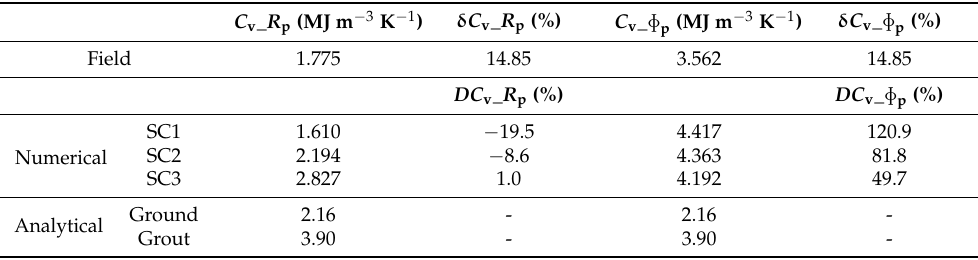
Table 11. Comparison of heat capacity obtained from the analysis of field tests and numerical simulations. HC of subsurface and grout are also